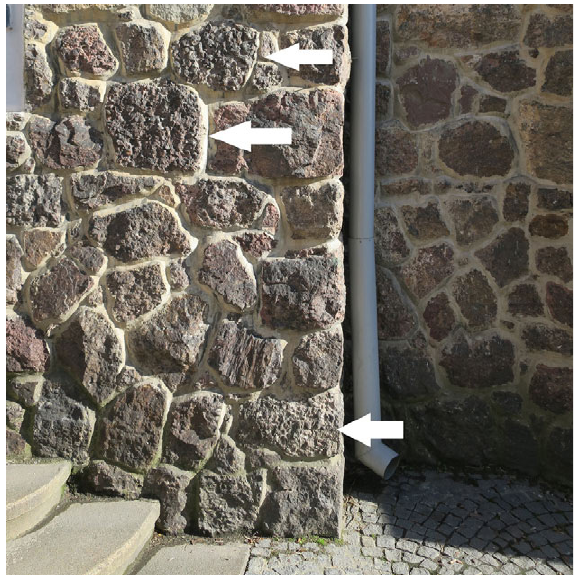
Fig. 4. Old Red conglomerate used as building stone, Biskupská Street (Photo: A. Bajer,